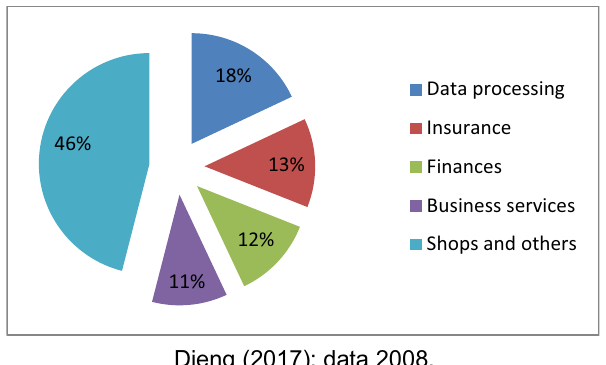
Fig. 6 Distribution of jobs according to the sectors in the B Euralille CBD ^ area. Dieng [14]; data